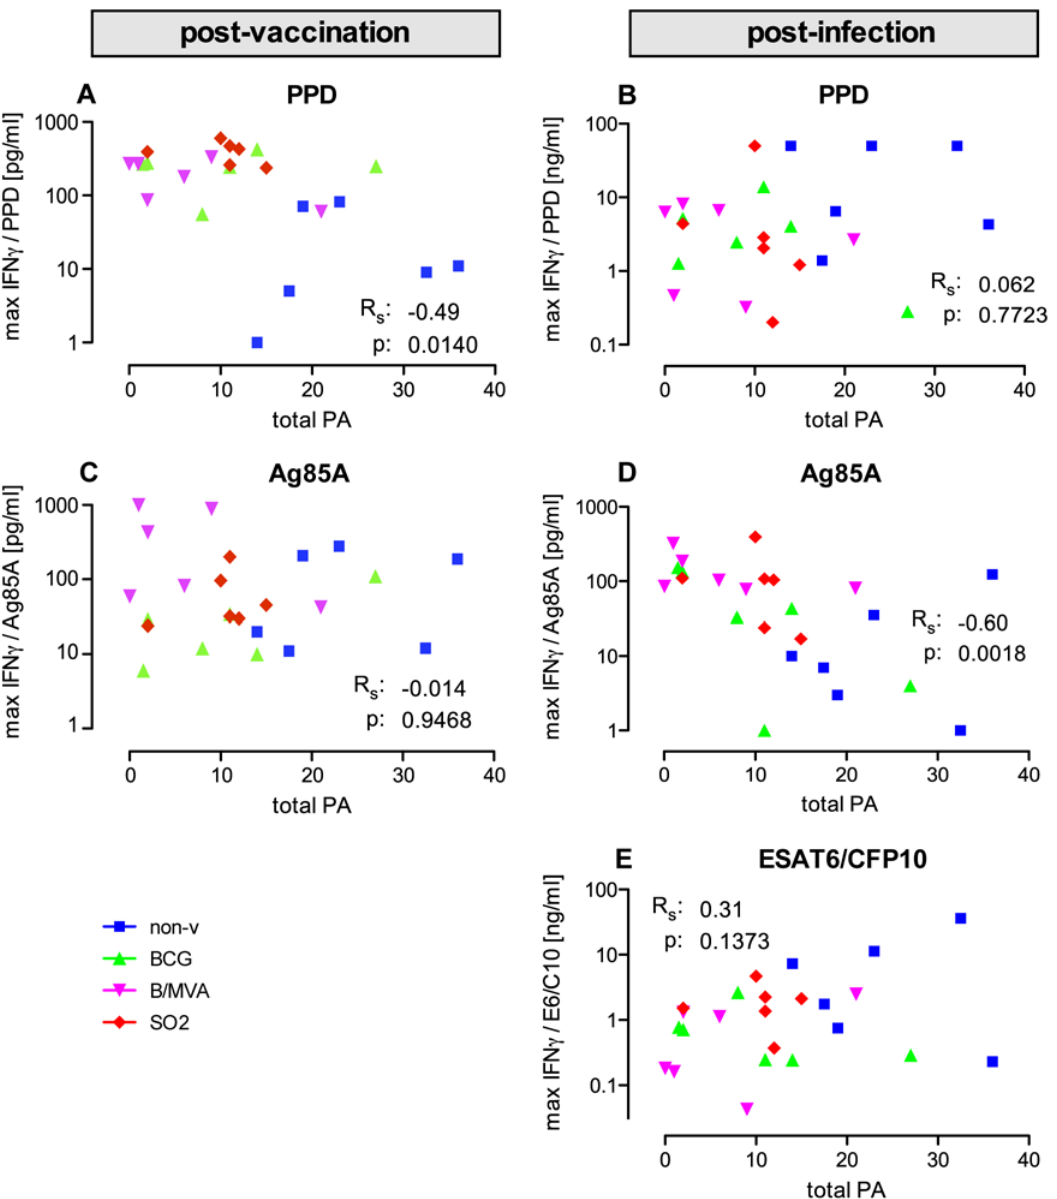
Figure 7. Immune correlations of disease. Maximal PPD-specific IFN c levels post-vaccination and maximal Ag85A-specific IFN c post-infection show significant inverse correlations with TB disease by total gross lesion PA scores. Maximal antigen-specific IFN c response levels are plotted per individual against total pathology scores (with colouring as indicated in the legend to figure 2 on group colouring) and post-vaccination and post- infection for PPD (A and B, respectively) and Ag85A (C and D, respectively), and for ESAT6-CFP10 fusion protein post-infection only (E).